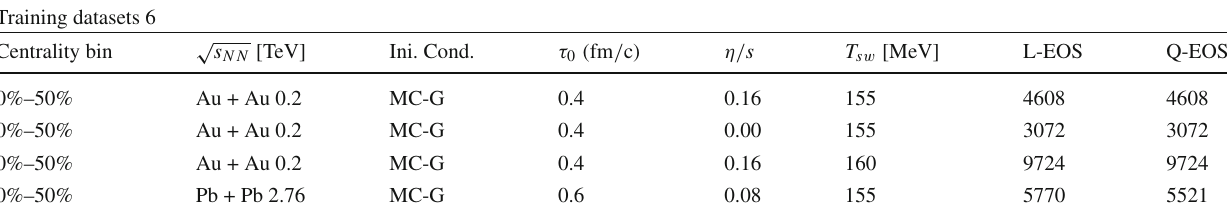
Table 8 Training datasets 6: numbers of cascade-coarse-grained spectra ρ c ( p T ,(cid:6)) computed by the iEBE-VISHNU hybrid model with the MC-Glauber initial conditions in the centrality range 0–50%